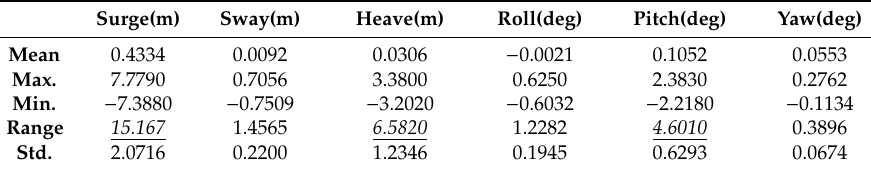
Table 8. 6-DOF motion statistics of WindFloat-type platform under a storm condition. Table 9. 6-DOF motion statistics of HexaSemi under a storm condition.